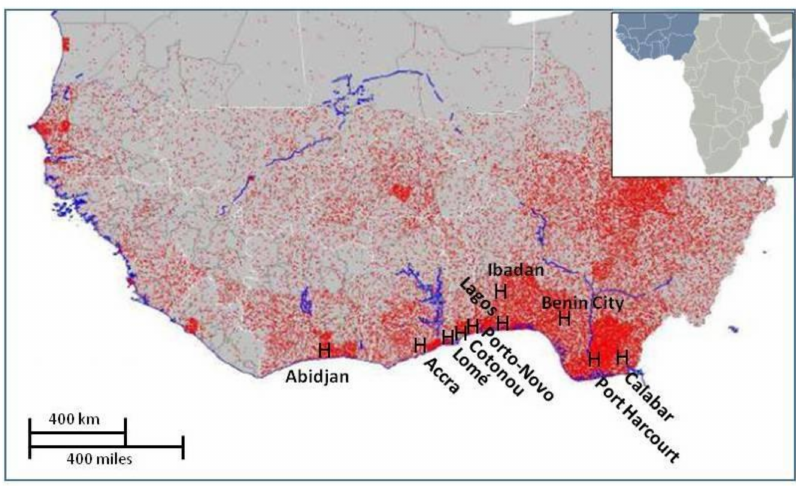
Figure 1. Predicted urbanization in West Africa in 2020. Each red dot represents 10,000 inhabitants. Modified from